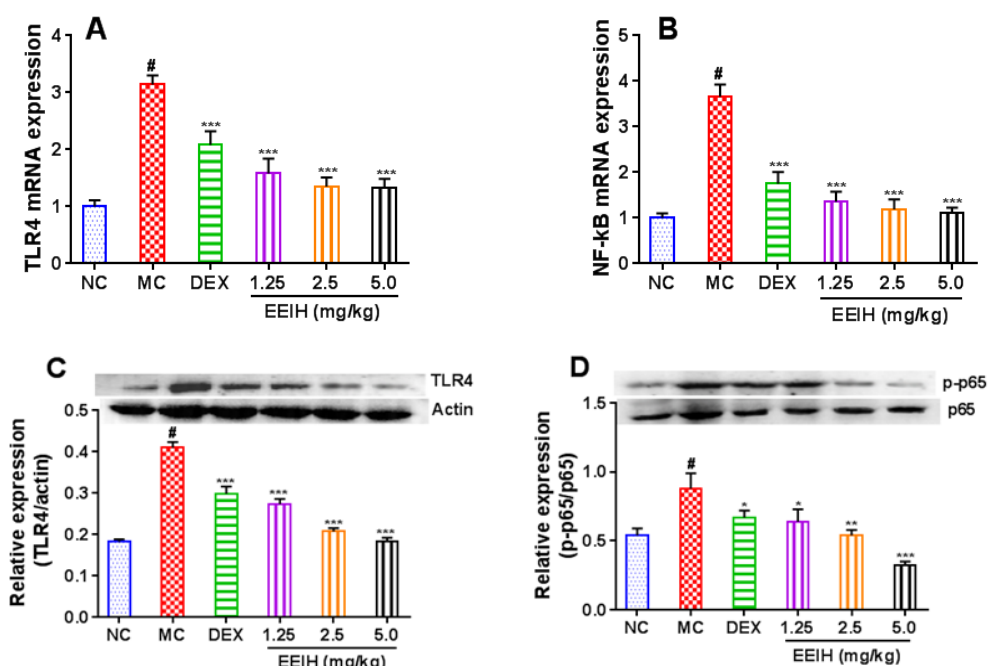
Figure 6. Effects of EEIH on the mRNA ( A , B ) and protein ( C , E ) expression levels of toll-like receptor 4 (TLR4) and nuclear factor-κB (NF-κB) p65 in liver tissue of LPS-treated mice. The figures shown were representative of five mice per group. The values are presented as the means ± SD ( n = 5). P values were determined by ANOVA and a Tukey post-hoc test. Significant differences compared to the normal control group (NC) are designated as # p < 0.001, those compared to the model control group (MC) as * p < 0.05, ** p < 0.01, and *** p < 0.001. DEX: dexamethasone (positive control).